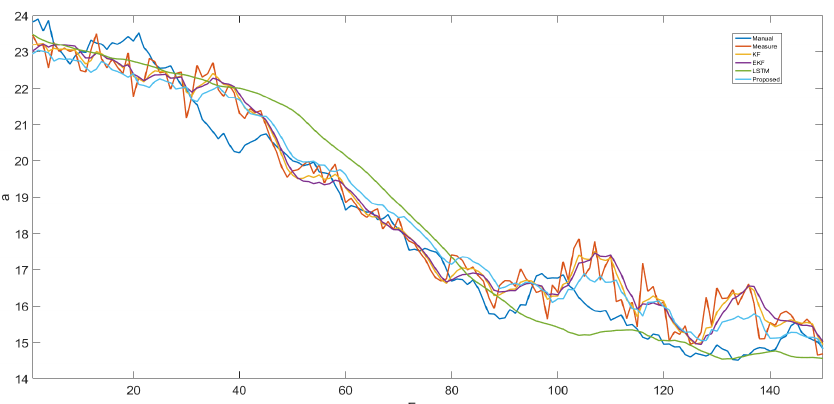
Figure 7. Five sets of test results using different methods on Subject